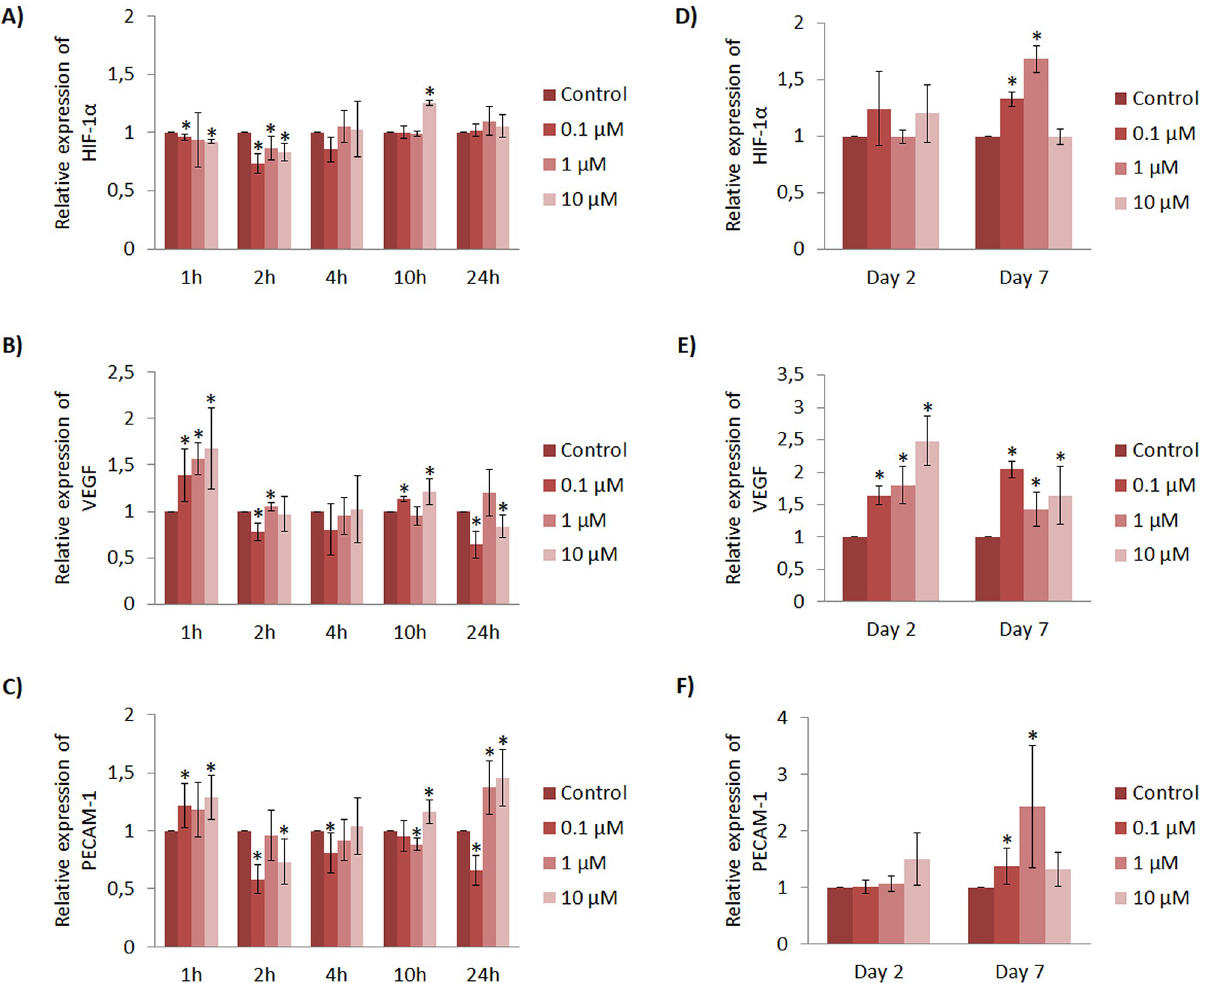
Fig 3. HUVEC gene expression profile cultured with Cu 2+ within short (hours) and longer (days) time points. Different Cu 2+ concentrations were evaluated at 1, 2, 4, 10 and 24h for the gene expression of (A) HIF-1 α , (B) VEGF and (C) PECAM-1. Different Cu 2+ concentrations were also evaluated at 2 and 7 days for the expression of (D) HIF-1 α , (E) VEGF and (F) PECAM-1. Data represented correspond to fold-changes compared to each time point control. Statistically significant differences were represented with � (p <